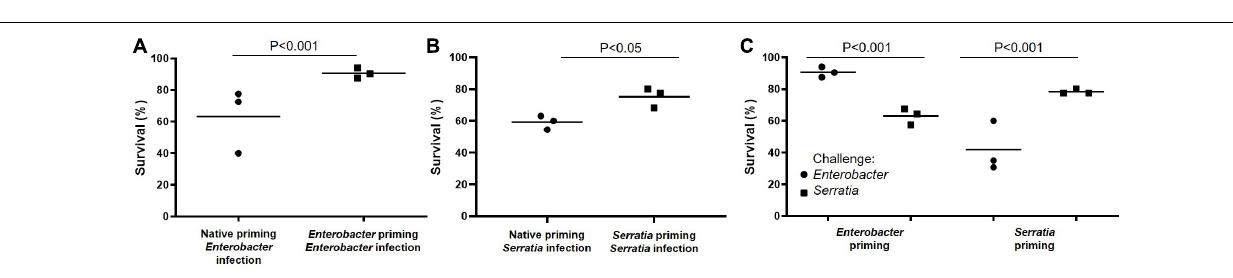
FIGURE 3 | Priming-enhanced antibacterial immunity was specific to the homogeneous bacteria. (A) Compared to native microbiota, the Enterobacter priming increased mosquito survival upon the Enterobacter challenge. (B) Compared to native microbiota, the Serratia priming increased survival upon the Serratia challenge. (C) Enterobacter priming increased the survival upon the Enterobacter challenge but not the Serratia challenge. The Serratia priming increased the survival upon the Serratia challenge but not the Enterobacter challenge. The survival data of each challenge were generated from three replicates, each had 40 mosquitoes. The survival difference was compared using Chi square